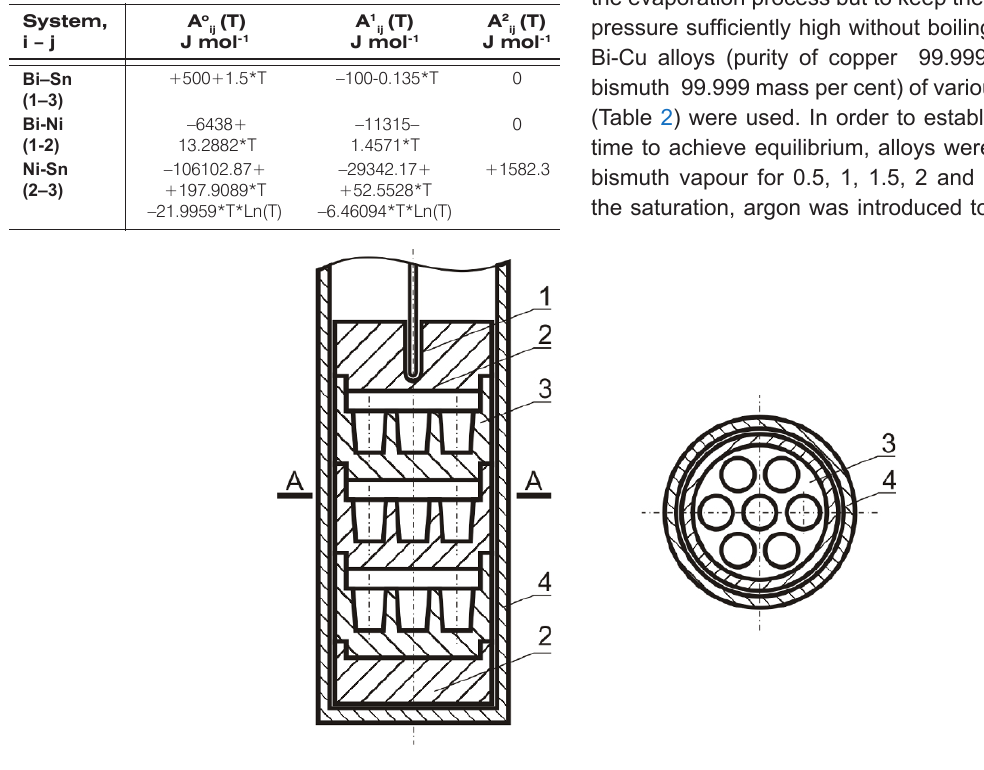
Figure 1. Schematic diagram of the apparatus used for the activity measurements: 1 – thermocouple, 2 – graphite cover, 3 – graphite blocks with groves for alloys,, 4 – vacuum chamber.